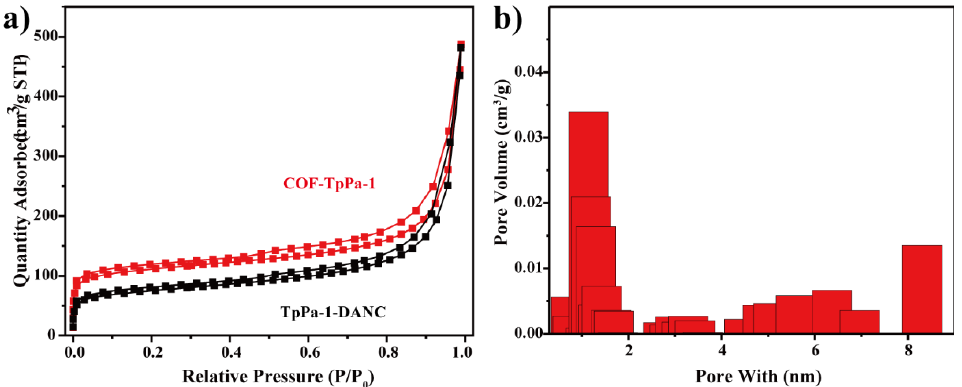
Figure 8. ( a ) Nitrogen desorption curves of TpPa-1 and TpPa-1-DANC; ( b ) Pore size distributions of the pure COF-TpPa-1.